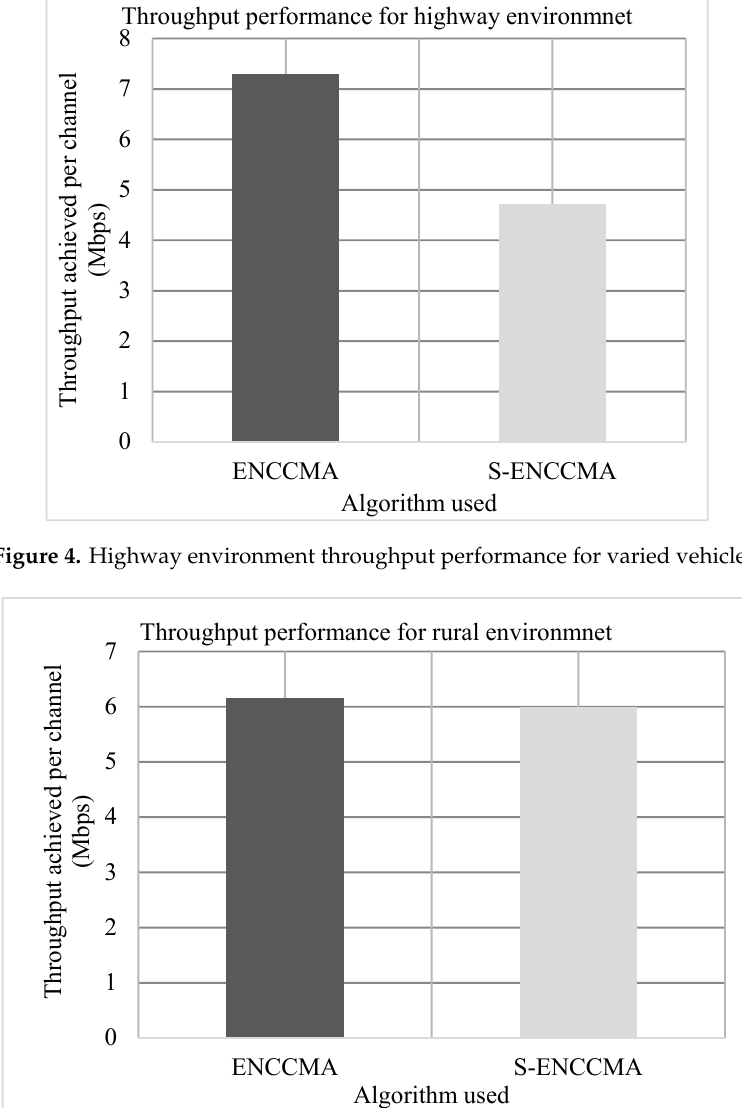
Figure 5. Rural environment throughput performance for varied vehicles.